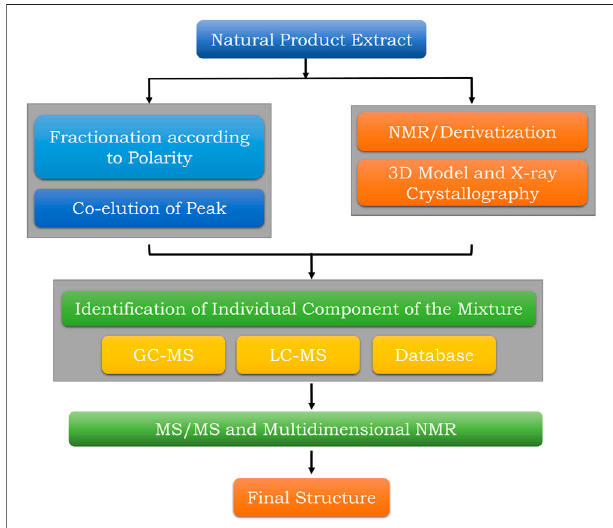
FIGURE 3 | Summary of stepwise structural elucidation techniques of natural